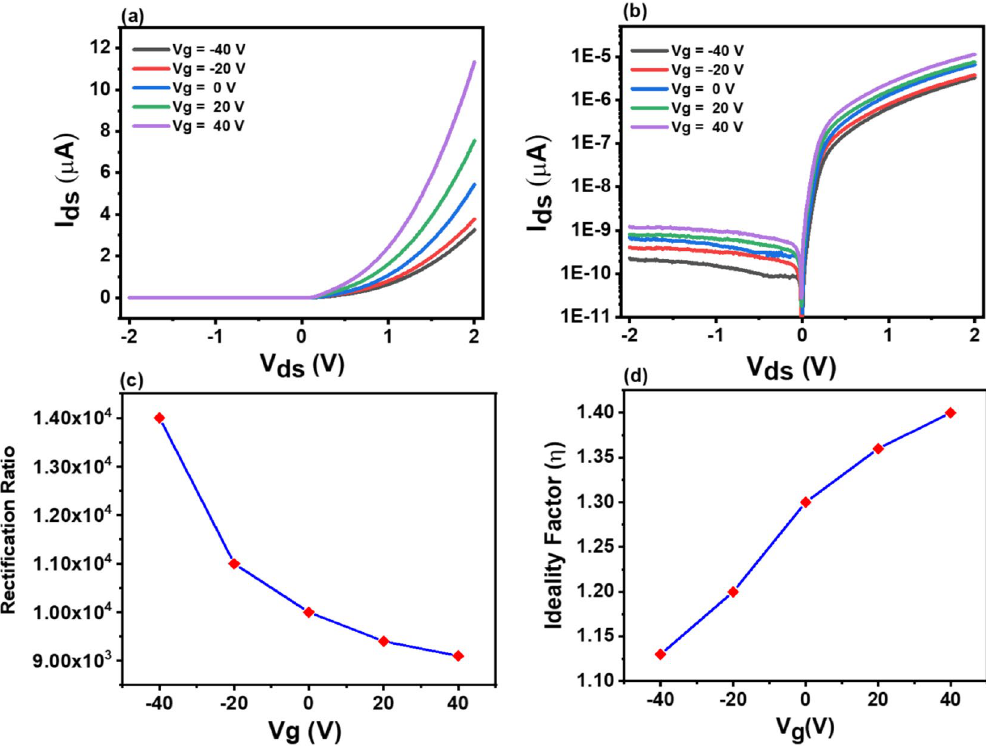
Figure 3. (a) The I–V characteristics of the p-GeSe/n-MoSe 2 heterojunction diode at different gate voltages. (b) The corresponding semi-logarithmic plots of output characteristics. (c) The gate dependent rectification ratio of p-GeSe/n-MoSe 2 heterojunction diode. (d) Gate dependent ideality factor of p-GeSe/n-MoSe 2 heterojunction diode.